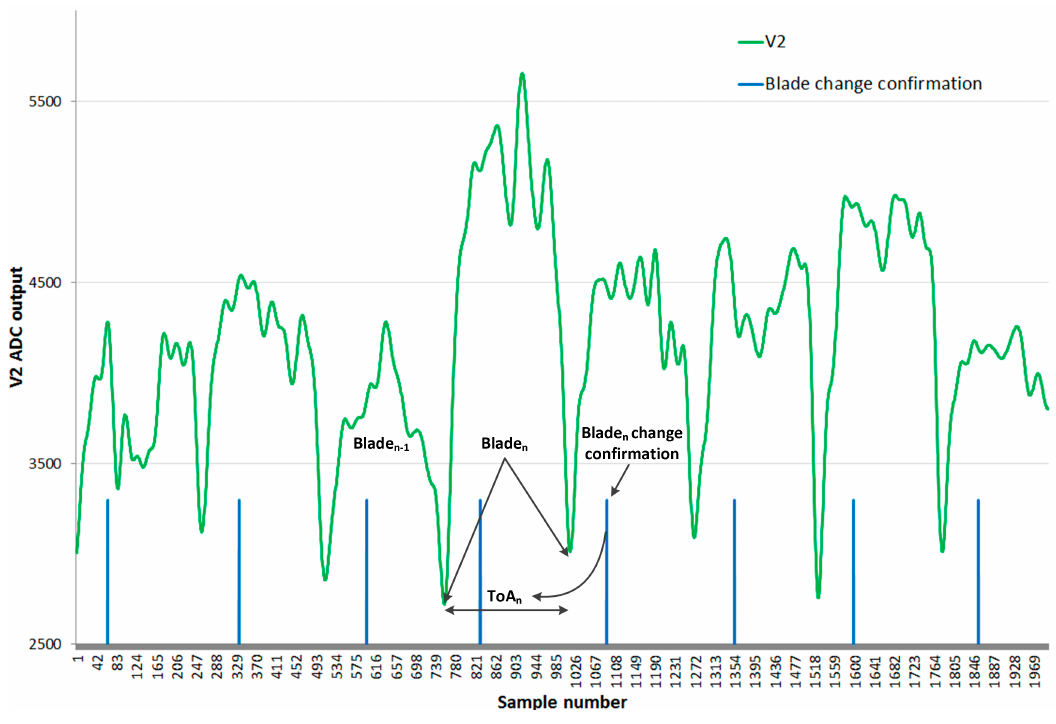
Figure 8. Change of blade confirmation.